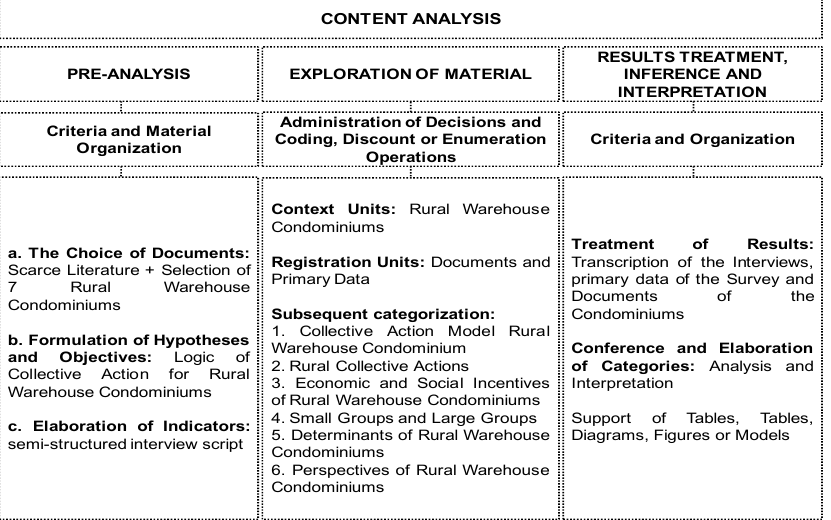
Figure 1. Applied Content Analysis.